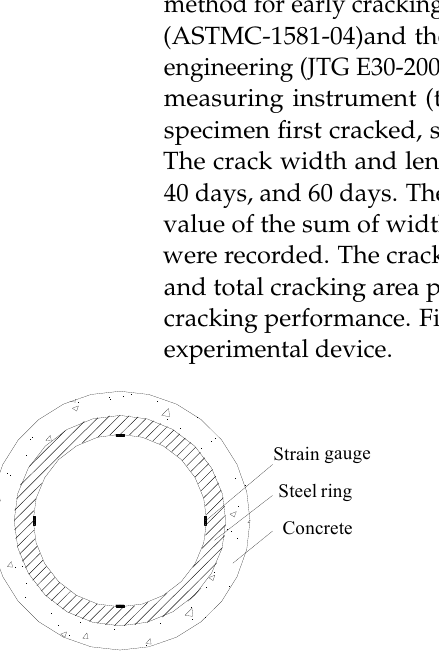
Figure 2. Schematic view of a ring specimen (unit: mm).